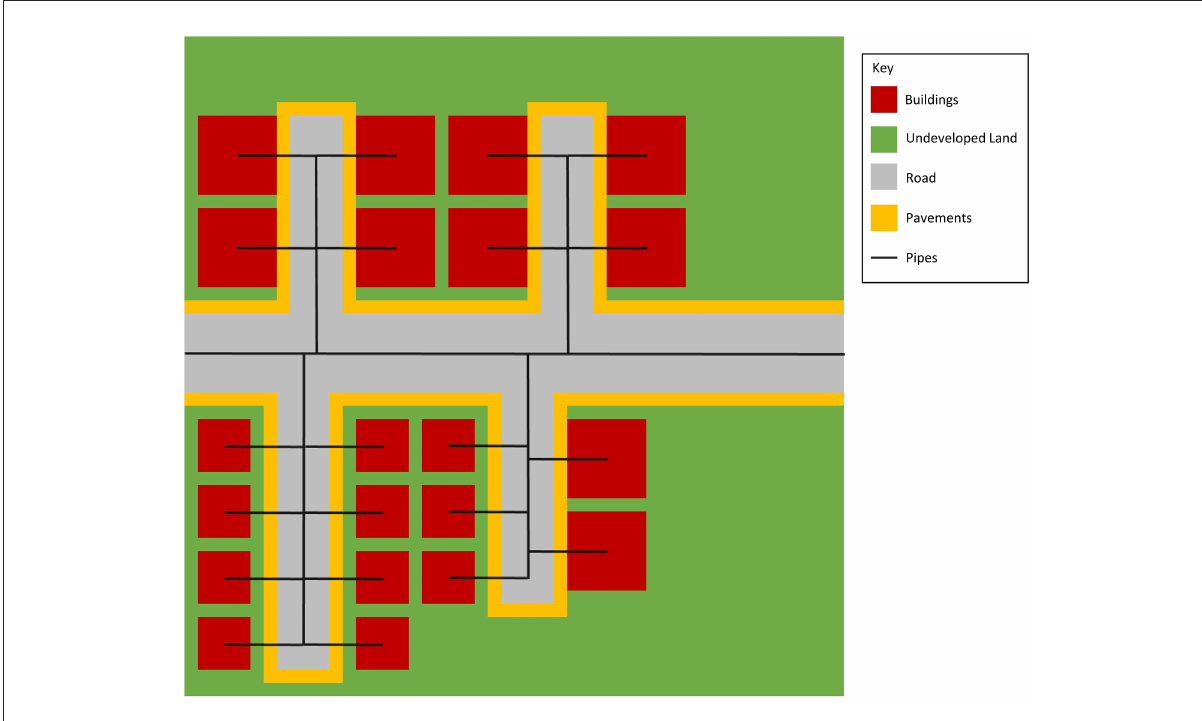
FIGURE7 The simulation stormwater pipe network for a